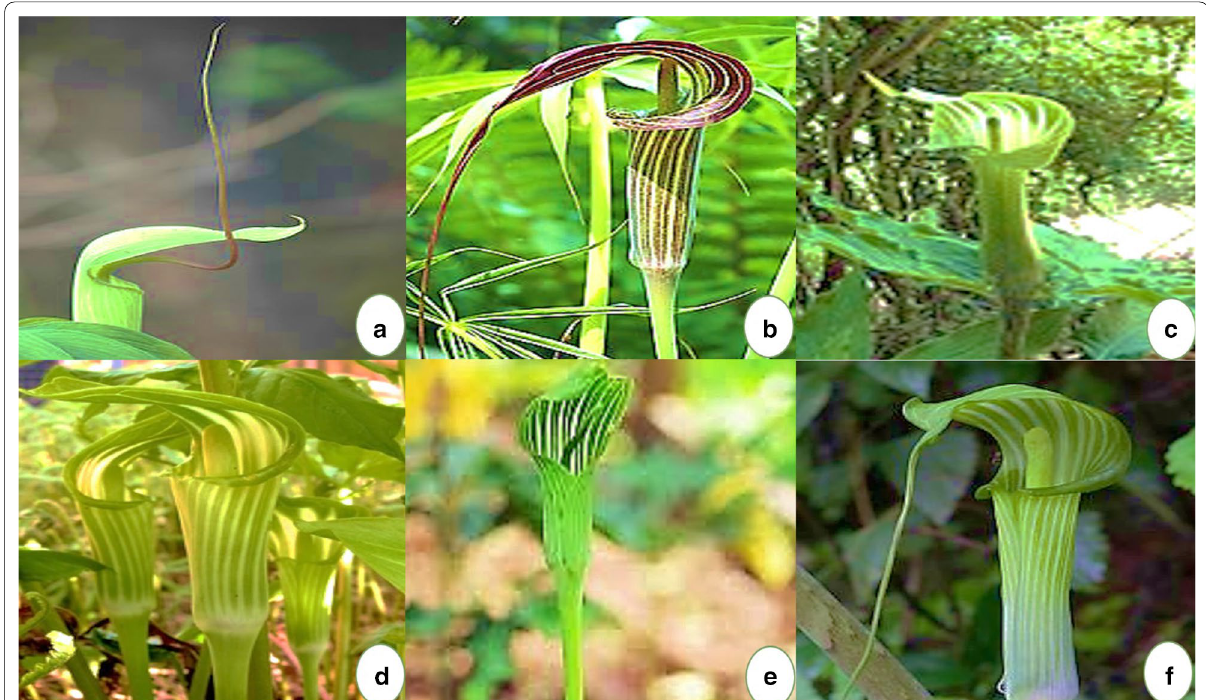
Fig. 1 a Arisaema tortousum , b Arisaema erubescens , c Arisaema serratum , d Arisaema amurense , e Arisaema yunnanense and f Arisaema